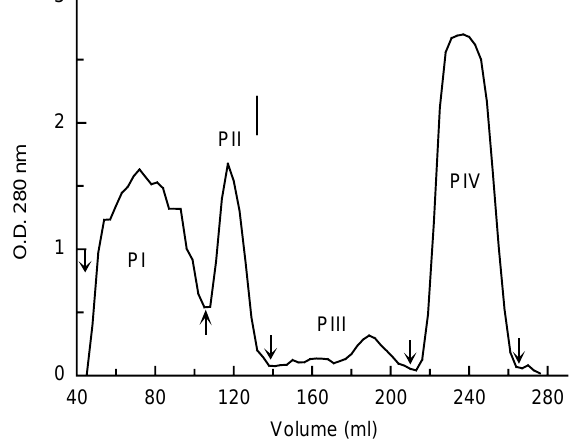
FIG. 1. Purification and isolation of casoparan peptide INKKI from casein hydrolysates (NZCASE). (A) Gel filtration chro- matography purification of NZCase after ultrafiltration in a 5000 Da membrane in a Sephadex G-10 column (4 (cid:4) / 65 cm 2 ) eluted with 0.02 M Na 2 PO 4 , pH 7.0, solution, monitored at 280 nm, flow rate of 12 ml/h and 3 ml of each fraction. Pool III (PIII) showed actitivity and was purified by